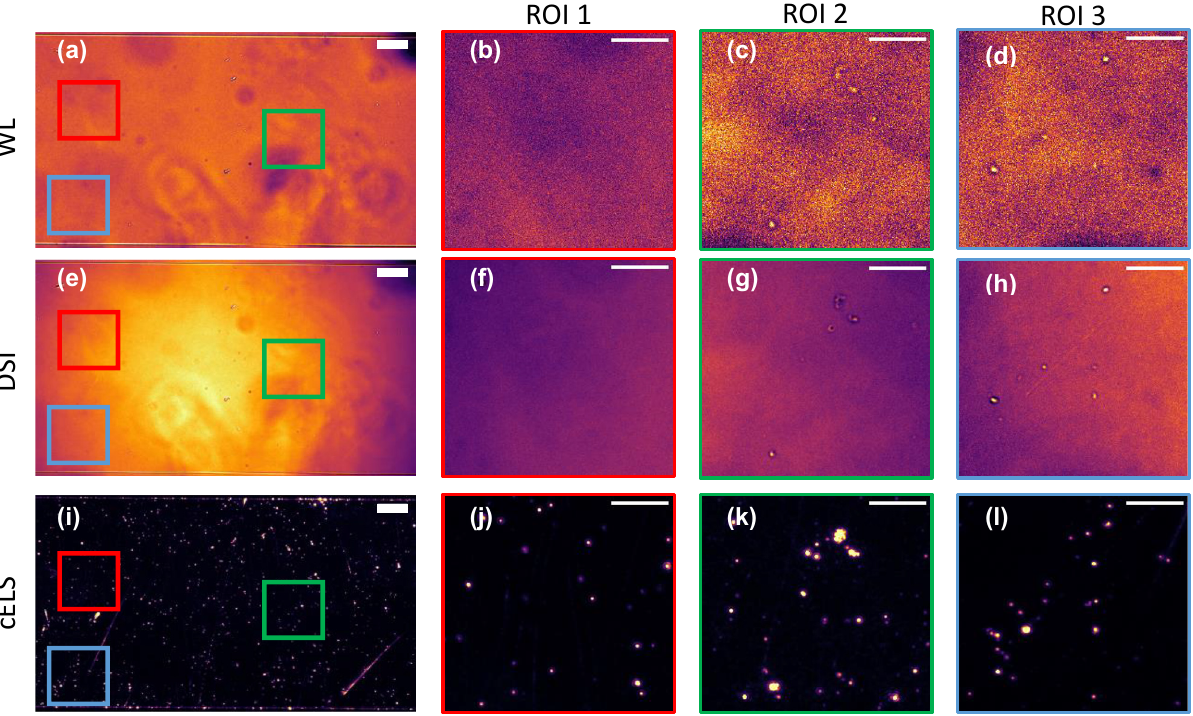
Figure 4: 100 nm polystyrene beads imaged using 20 × /0.45NA with white light (WL), dynamic speckle illumination (DSI) and cELS. (a, e, i) 100 nm beads imaged using WL, DSI and cELS respectively. Scale bar 50 μ m. A few regions of interest, ROI 1–3, with aggregated and sparse beads are chosen within the FoV enclosed by red, green and blue boxes which are blown up and displayed. (b, c, d) WL images of 100 nm beads, (f, g, h) 100 nm beads imaged in DSI mode and (j, k, l) 100 nm beads imaged using cELS. Scale bar 20 μ m in the blown-up